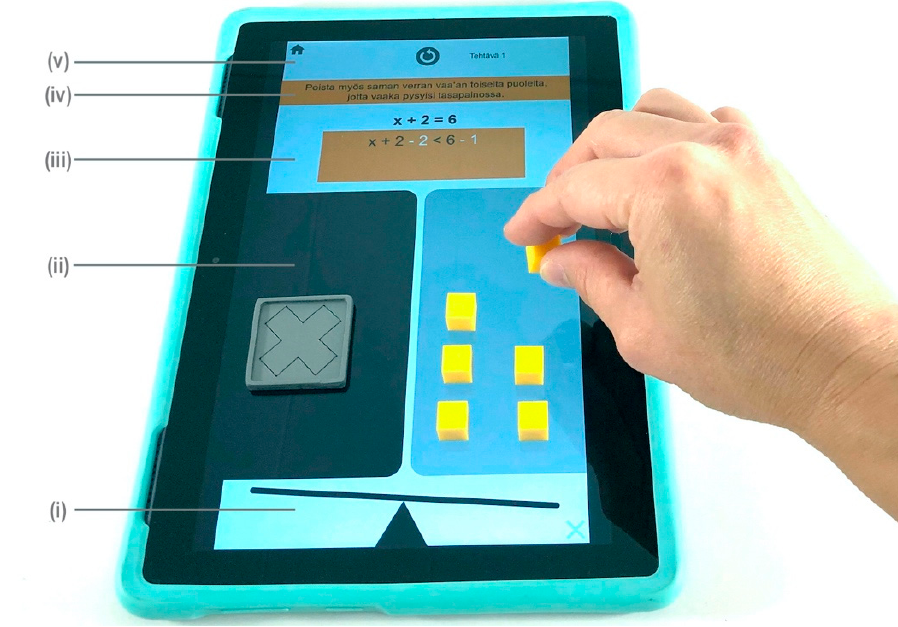
Figure 6. GUIs on the screen from bottom to top. ( i ) Scale; ( ii ) Working zone; ( iii ) Mathematical symbol zone; ( iv ) Text window; ( v ) Navigation and operation